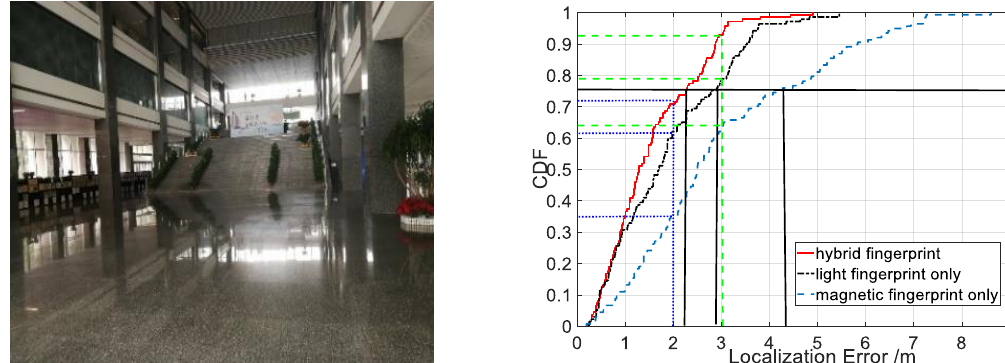
Figure 21. Localization accuracy of LiMag using different types of fingerprints in open-plan area.